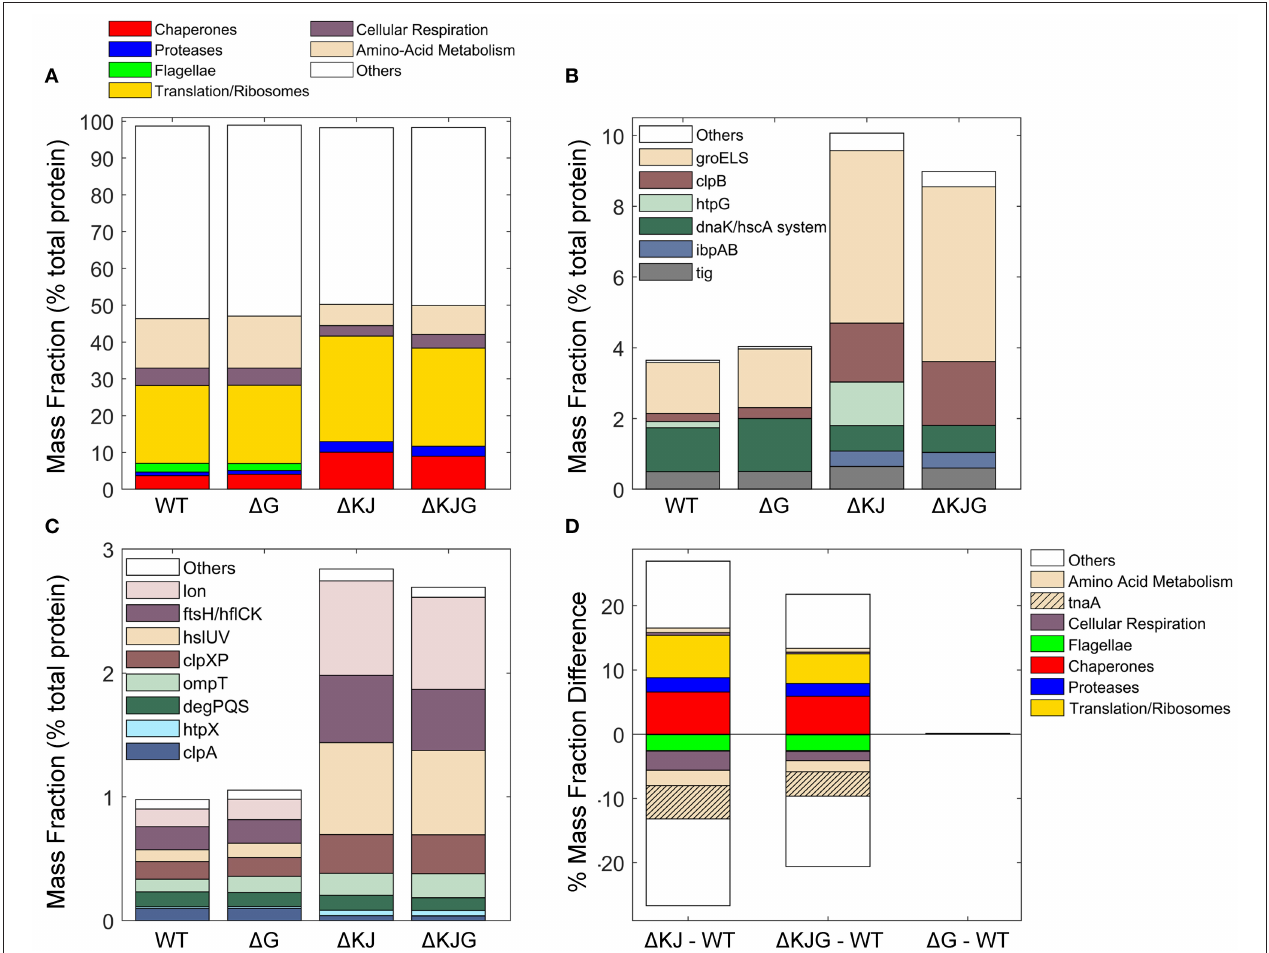
FIGURE 3 | Analysis of different protein functional categories in the Escherichia coli variants. (A) Distribution of the principal functional categories of significantly quantified proteins in the four E. coli strains, Data are presented as mass fractions. Functional categories were manually defined according to both previous knowledge from the literature and Gene Ontology (GO) annotations. (B) Mass fractions of individual proteins belonging to the chaperone category. The dnaK/hscA system (dark green bar) comprises dnaK, dnaJ, grpE, cbpA, djlA, hscA, and hscB. The white bar (“Others”) comprises hslO, and spy. (C) Mass fractions of individual proteins belonging to the protease category. (D) Mass fraction differences (expressed in % of the total intracellular proteins) between wild type and the various deletion mutants. When absent in their respective mutants, the proteins DnaK, DnaJ, and HtpG were excluded from the